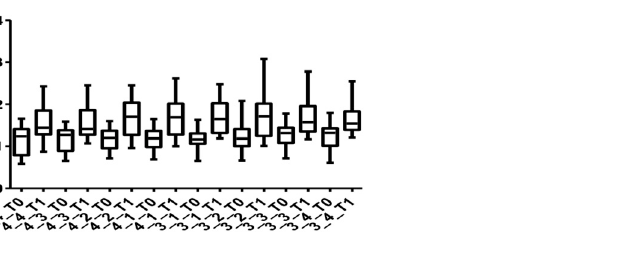
Figure 10. Distribution of CBCT values at the cervical level, lower arch, for all teeth up to the first premolars at T0 and T1.